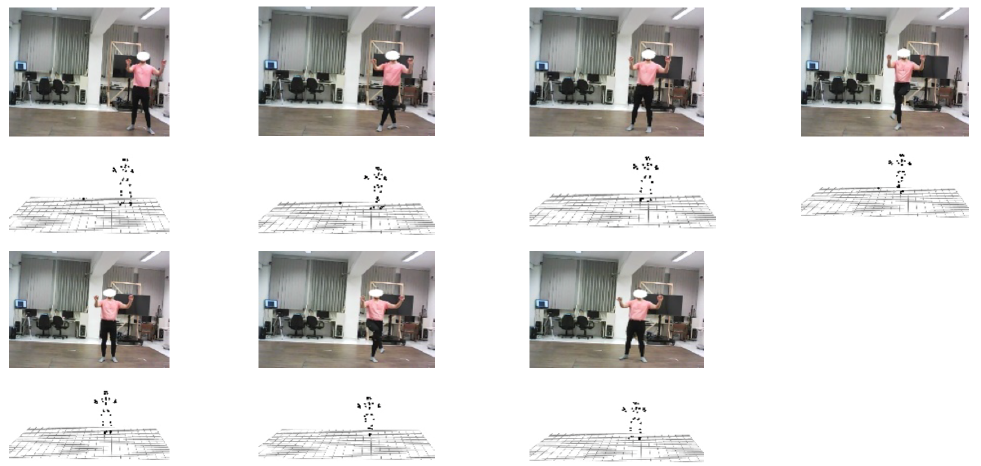
Figure 12. An instance that illustrates seven frames from the Syrtos at 3 beats